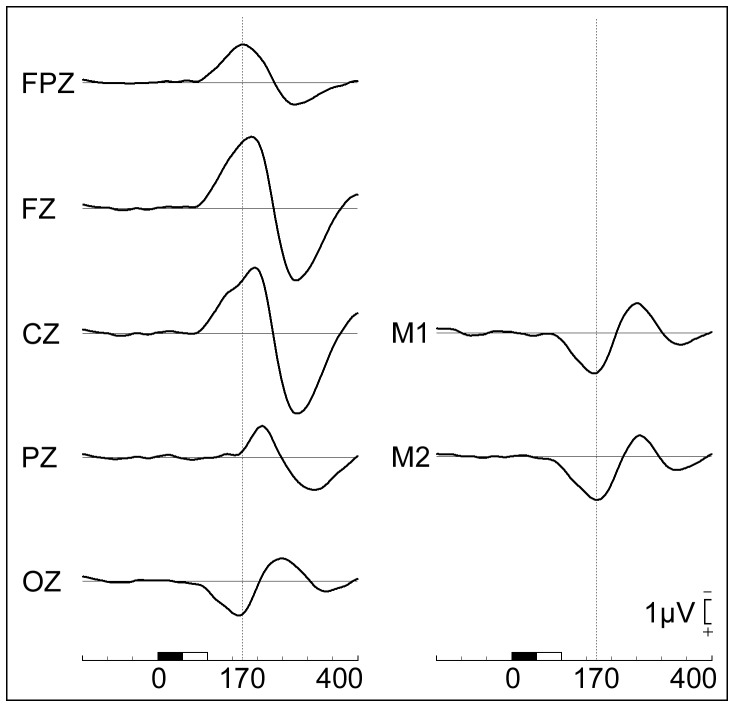
Grand average MMN waveforms.Grand average deviant minus standard difference waves recorded from midline and mastoid sites. The early MMN is maximal at Fz and phase reverses at mastoid sites. Prior to 160